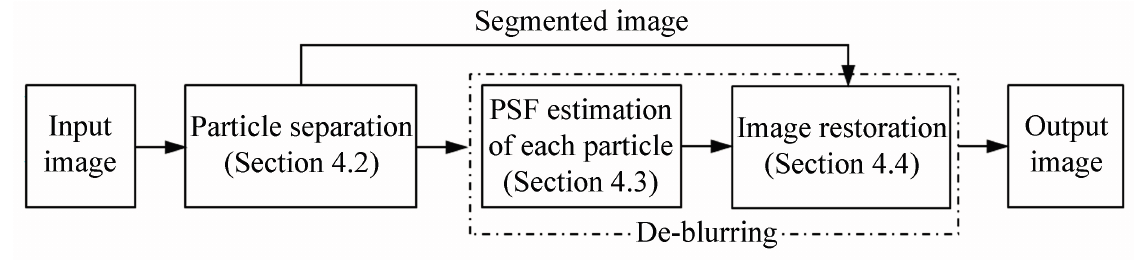
Figure 5. Flowchart of the proposed